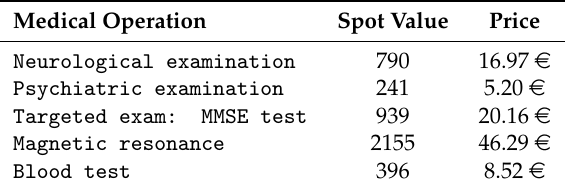
Table 1. Cost of medical